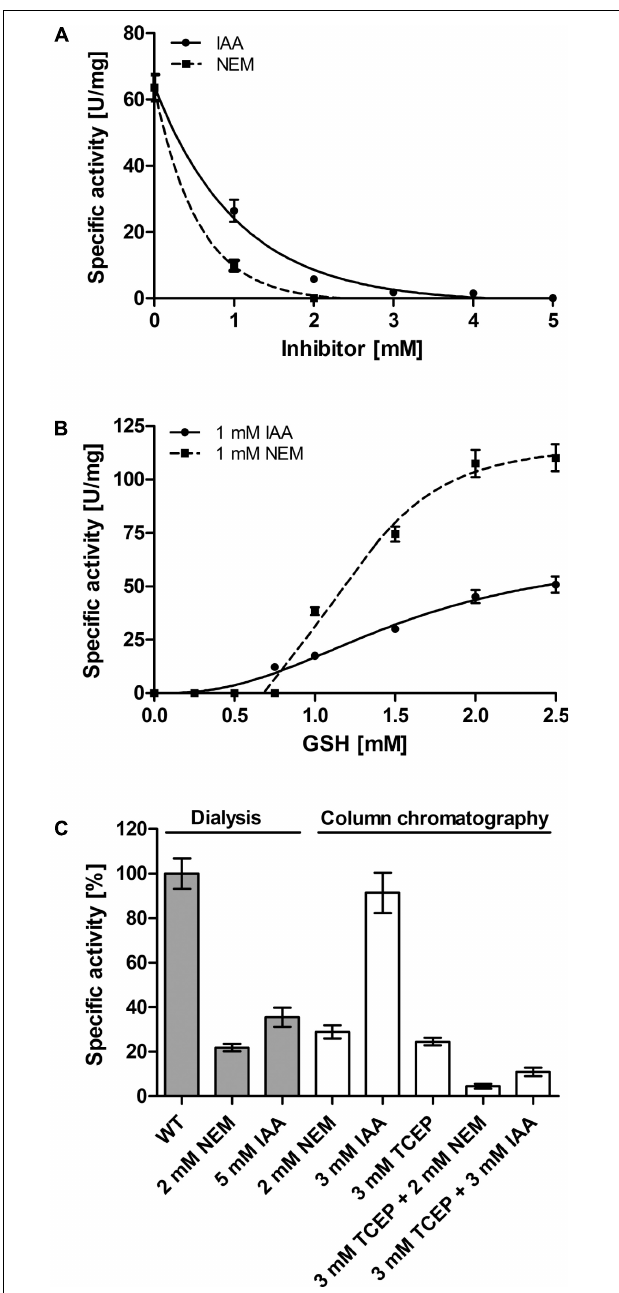
FIGURE 9 | Effect of Inhibitors on the Ac PDO. (A) Residual PDO activity with 1 mM GSH, sulfur and N -Ethylmaleimide (NEM) or iodoacetamide (IAA) after adding the substance directly to the enzyme assay mixture. (B) Same as in A only that the GSH concentration was varied. (C) Residual PDO activity after pre-incubation of the Ac PDO with NEM, IAA, or Tris(2-carboxyethyl)phosphine (TCEP). Error bars represent the standard deviation from triplicate